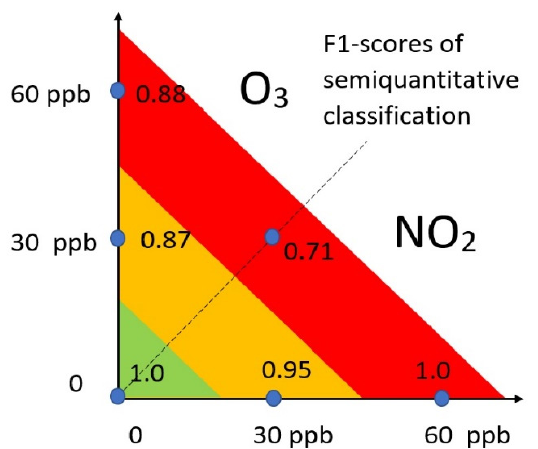
Figure 1. Air quality scale with discrete gas concentration points used in the study. The F1 scores shown are figures of merit for a concrete sensor array and machine learning algorithm described in the Results section. The model used was artificial neural network (ANN) using four sensors (see Table 1). Table 1. PLD functionalization parameters for the sensors used in the experiments. Sensor